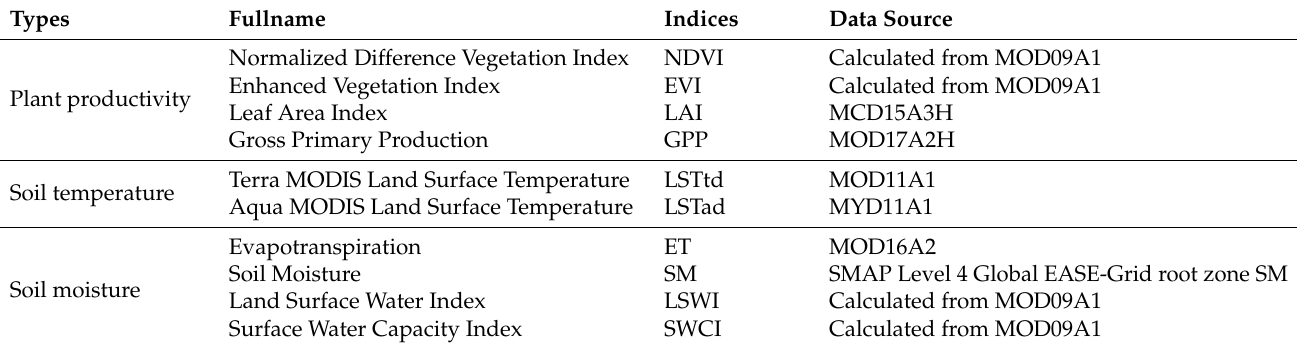
Table 2. Summary of all remote sensing indices used in this